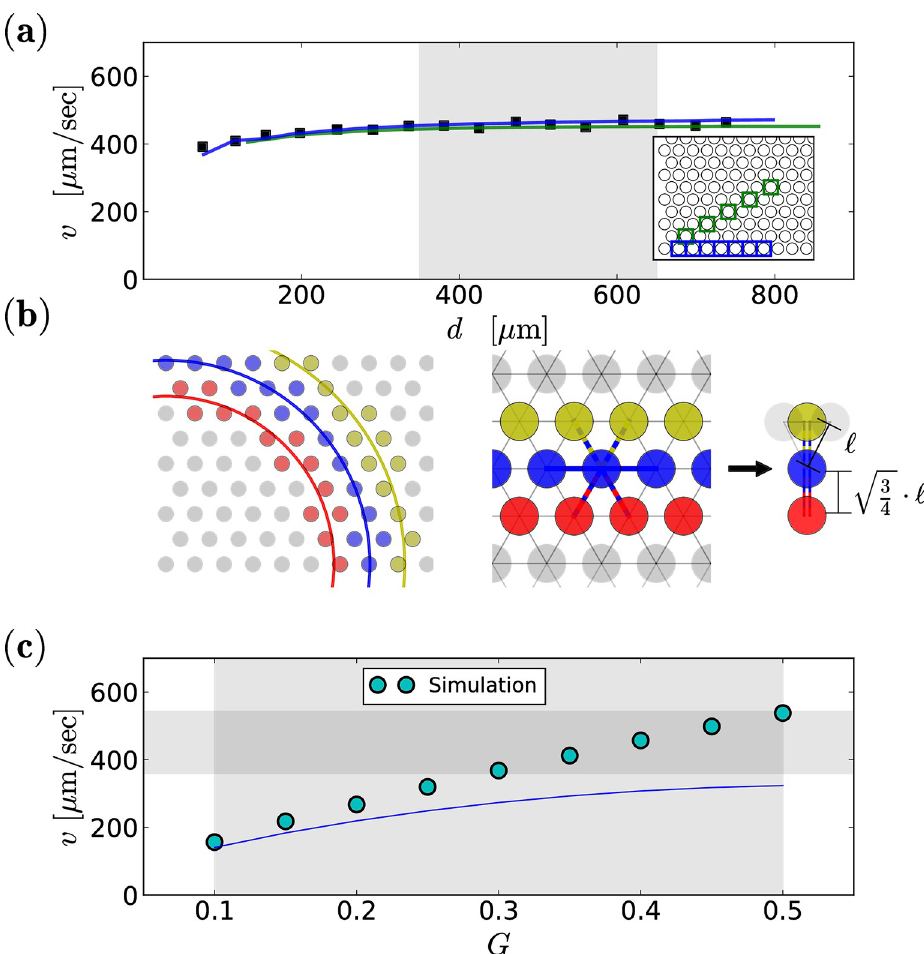
Fig 3. Wave speed: Measurement and dependence on GJ coupling. Neural groups with simultaneous burst onset of an exemplary simulation (time resolution Δ t = 0.1 seconds) are shown in the panel (a) left, for three consecutive time bins in different colors. At large distances from the origin, the shape of a wavefront can be approximated as planar, cf. (a) middle. The mechanism of burst propagation can then be mimicked by a one-dimensional situation. Therefore in our theoretical derivations, the distance and coupling strength has to be modified, cf. (a) right and details in the main text. Squares in (b) represent the speed of the concentric wave ( G = 0.4) as a function of the distance from the wave’s origin (lower left corner of the simulation domain), measured as described in the text. Alternatively, the speed can be assessed by measuring burst onset times along different fixed directions of the network, i.e. at blue and green sites shown in the inset of (b) . The resulting wave speeds as functions of distance (blue and green lines) agree closely with the concentric method (squares in (b) ). The speed shown in (c) is the mean value of simulation data (symbols) of the shaded area in (a) as a function of the GJ coupling G . Simulation results are compared to v 2 ( G ), Eq (9). The vertical D and horizontal shadings indicate the physiological range of G (see Methods) and the observed velocities in the rabbit retina [11],